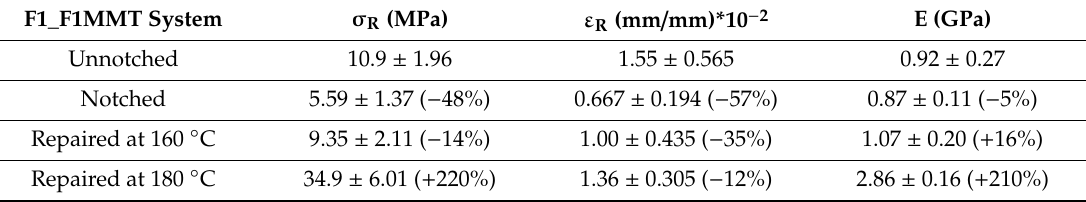
Table 4. Flexural properties of nanofilled PBT, repaired at di ff erent